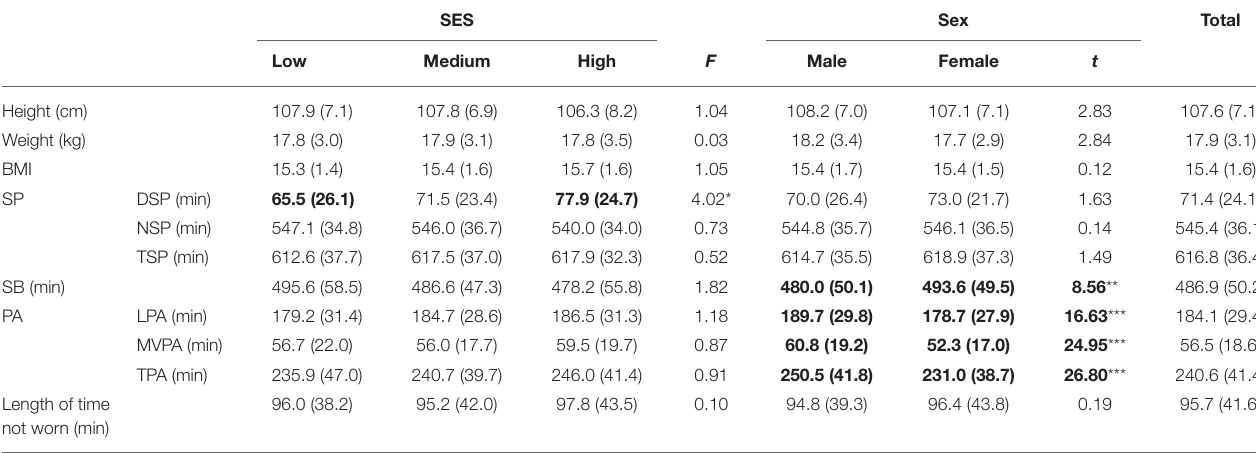
TABLE 3 | Basic situation of important variables in preschool